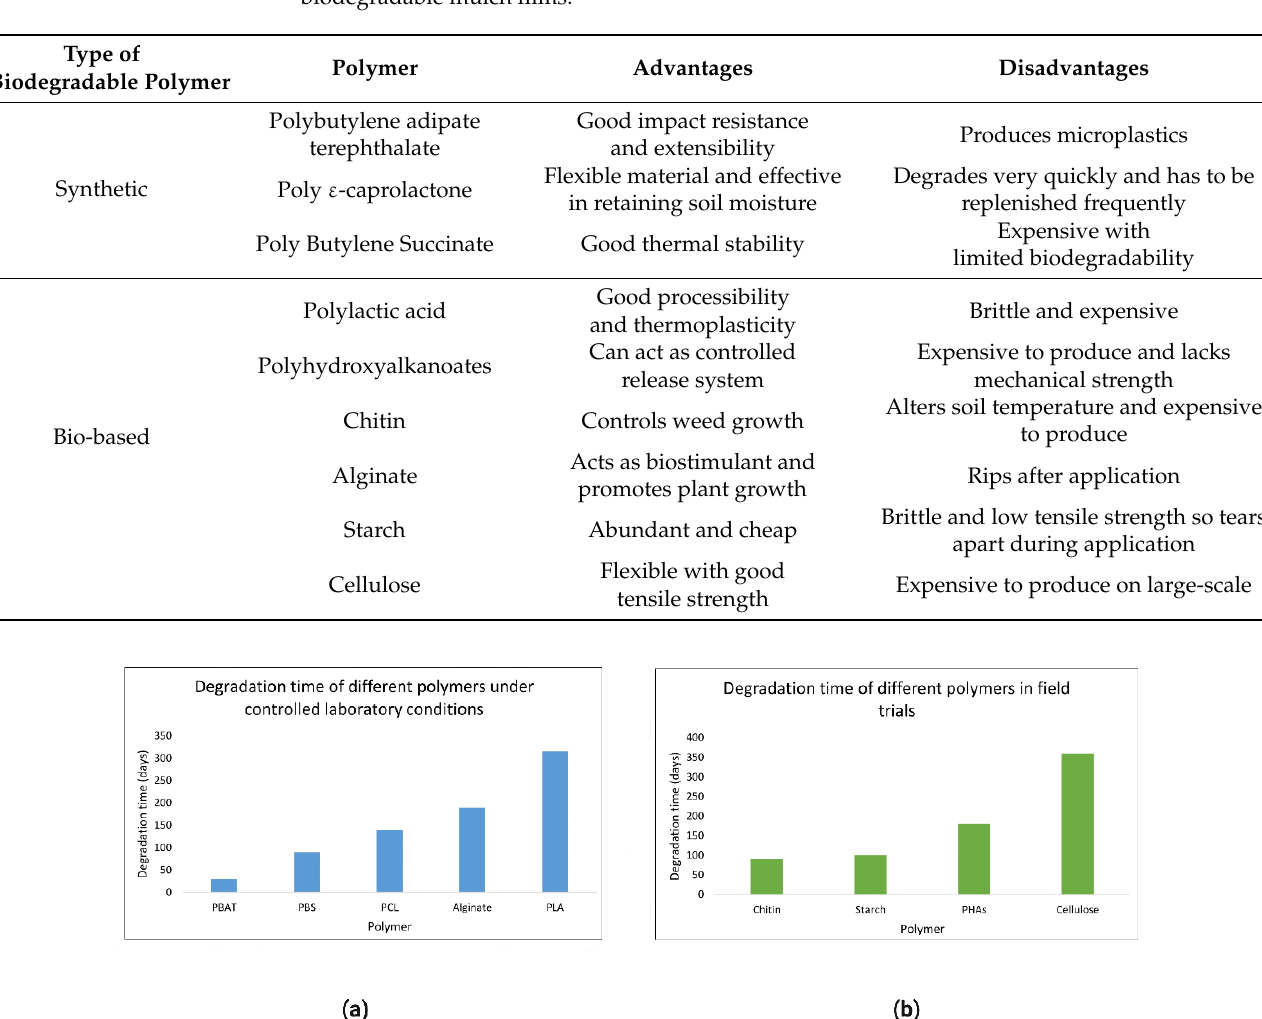
Table 2. Comparison of the advantages and disadvantages of different synthetic and bio-based bi- odegradable mulch films .